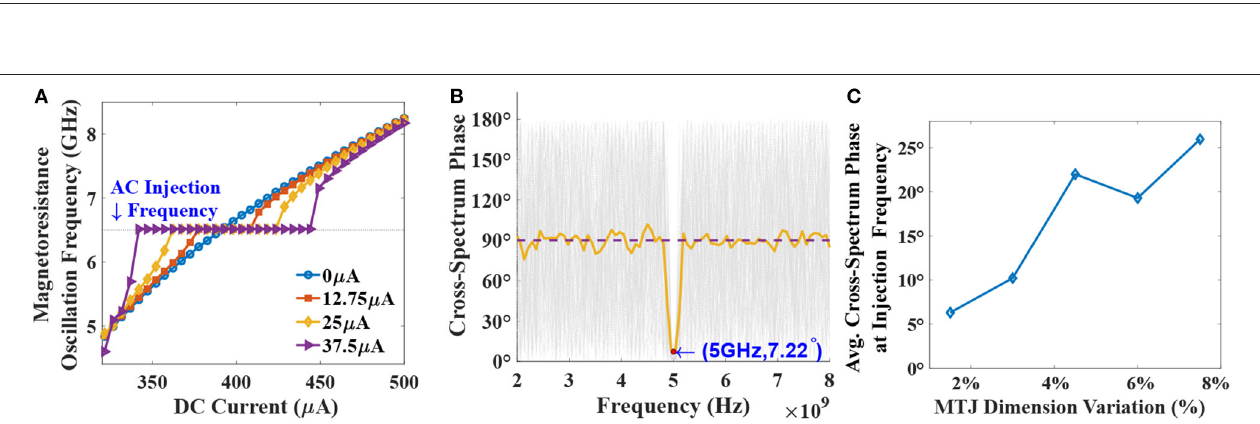
FIGURE 3 | Electrical emulation of astrocyte induced neural synchrony is shown where an astrocyte device drives an alternating current through a common HM substrate to phase-lock the MTJ oscillator neurons.